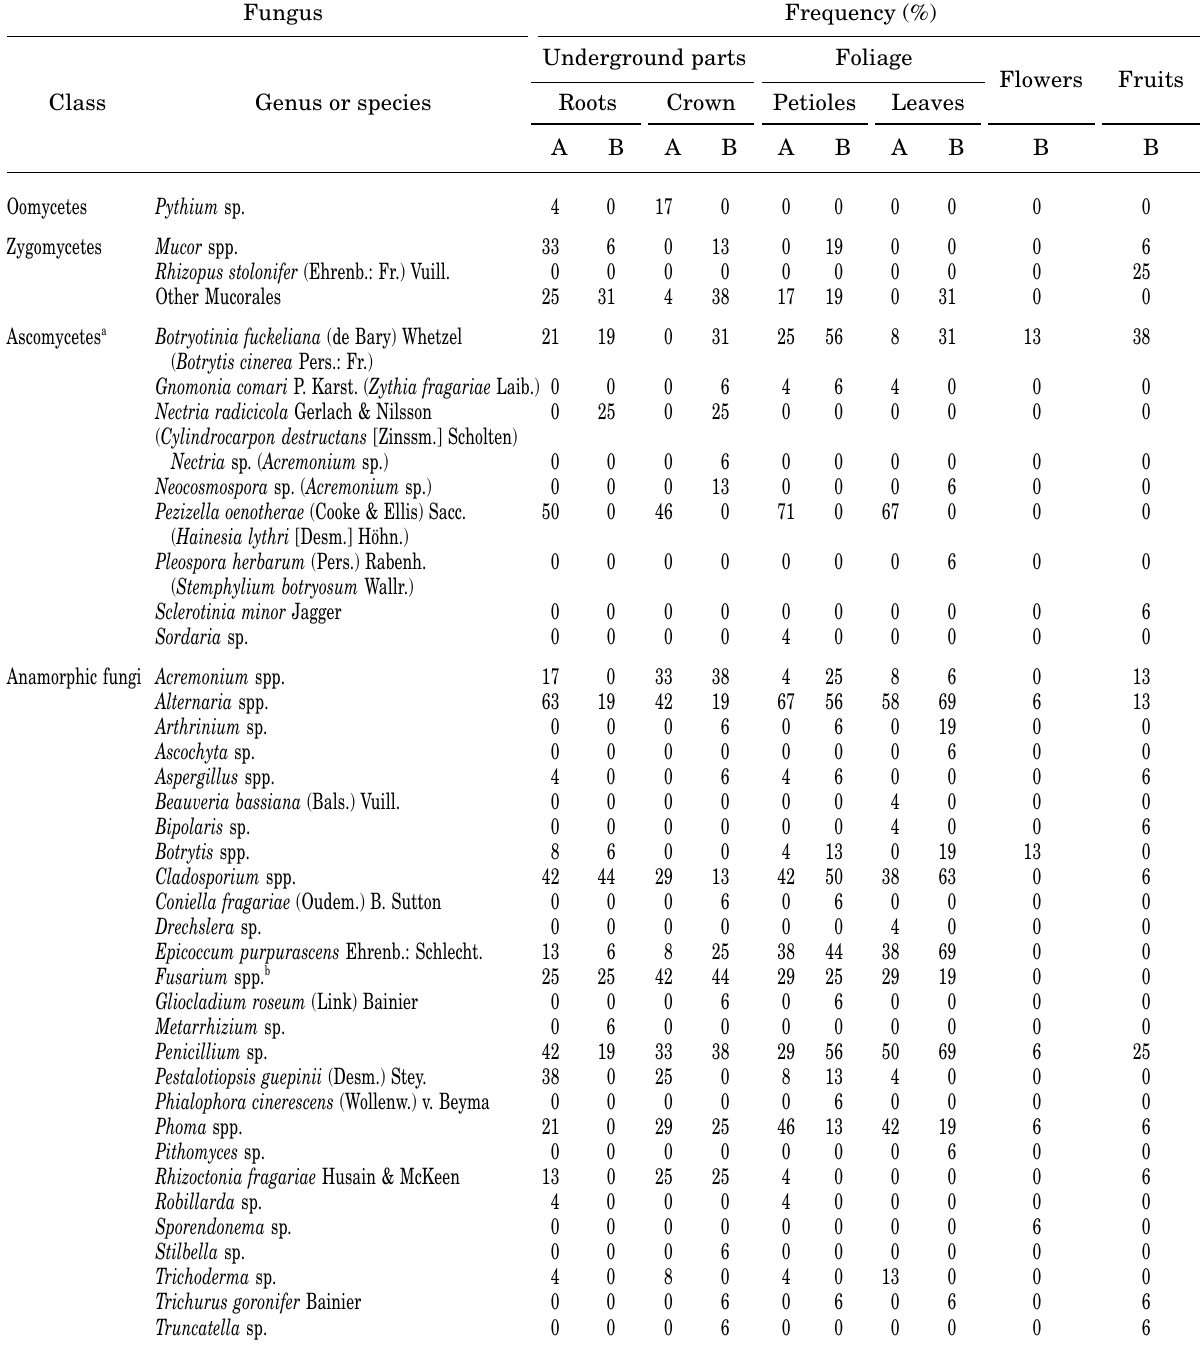
Table 1. Fungi isolated from different parts of symptom-free strawberry plants, expressed as a percentage of (A) 24 frigo plantlets and (B) 16 field grown